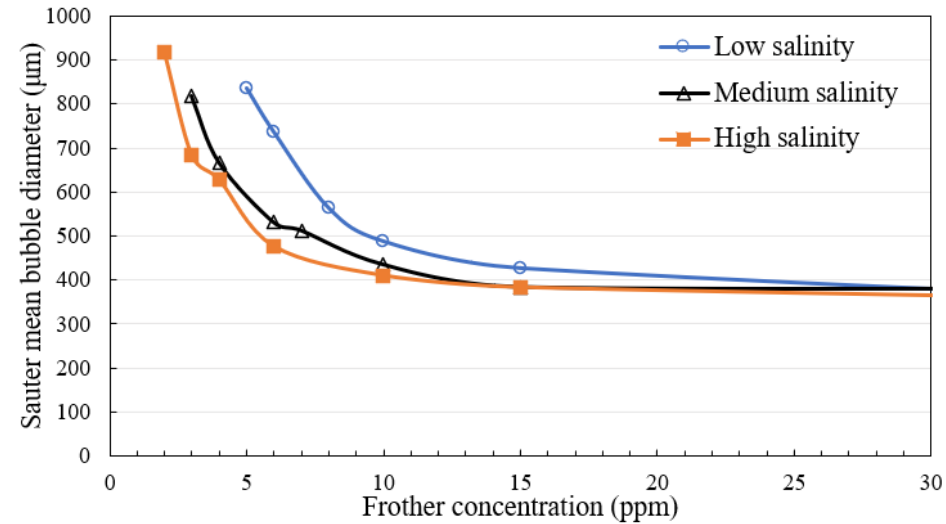
Figure 11. CCC comparison of Frother A at three water salinities.